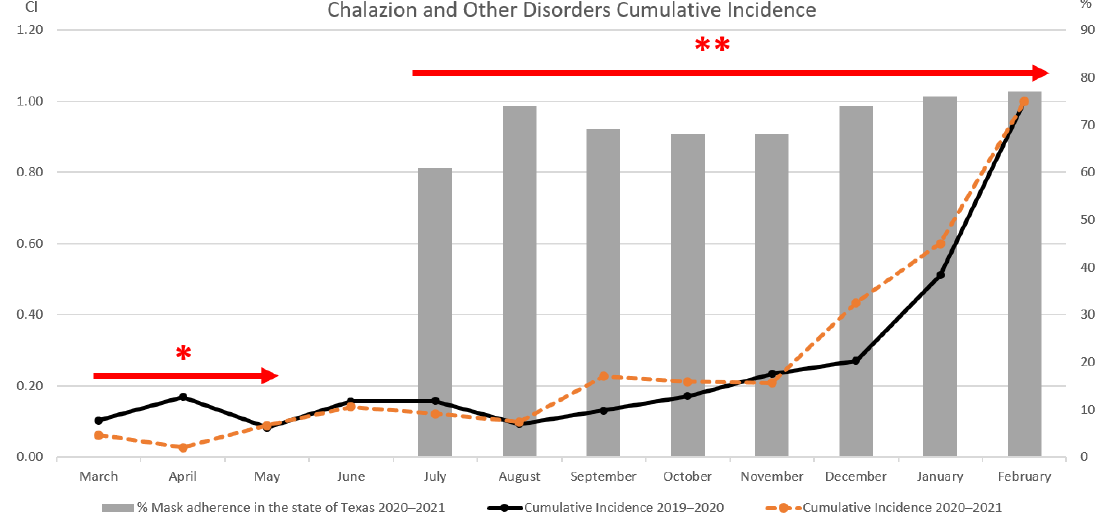
Figure 2. Cumulative chalazion and other disorder incidence with Texas mask adherence. During the UTMB lockdown period in early 2020 (arrow with one asterisk), the cumulative in-